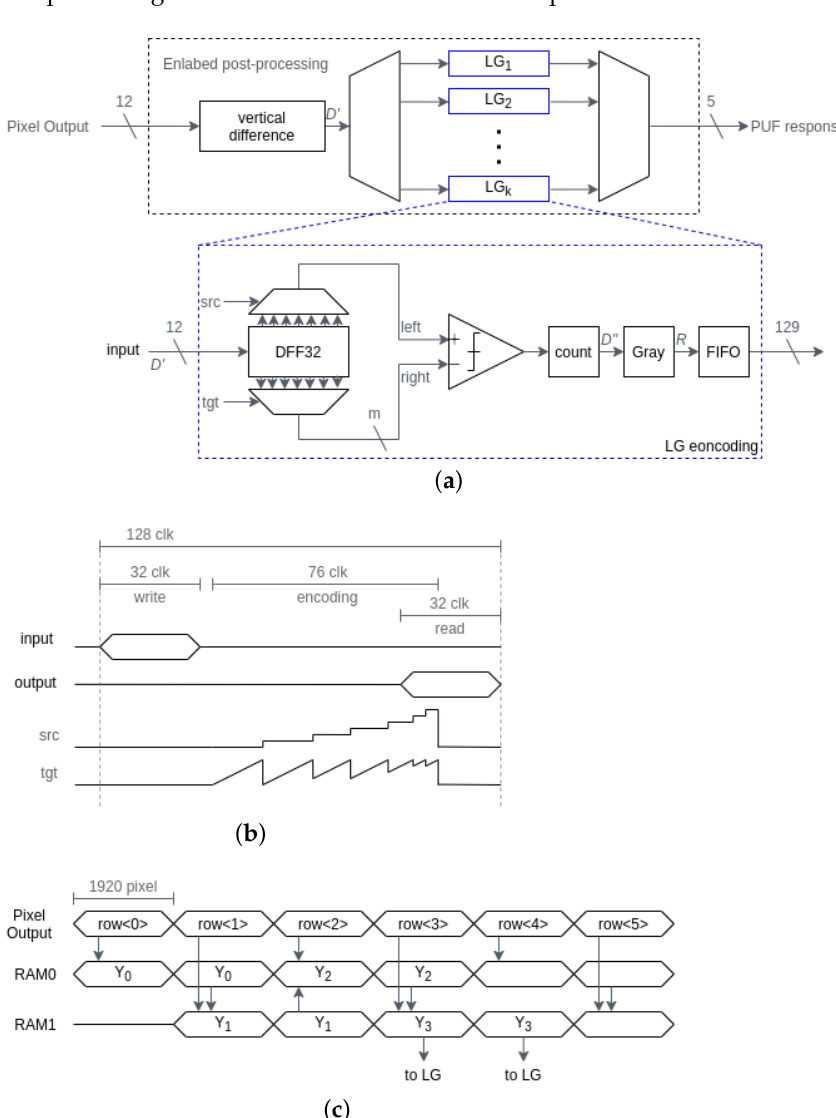
Figure 11. L.G. post-processing circuit. ( a ) Block diagram. ( b ) Timing diagram of LG encoding when m = 8. ( c ) Timing